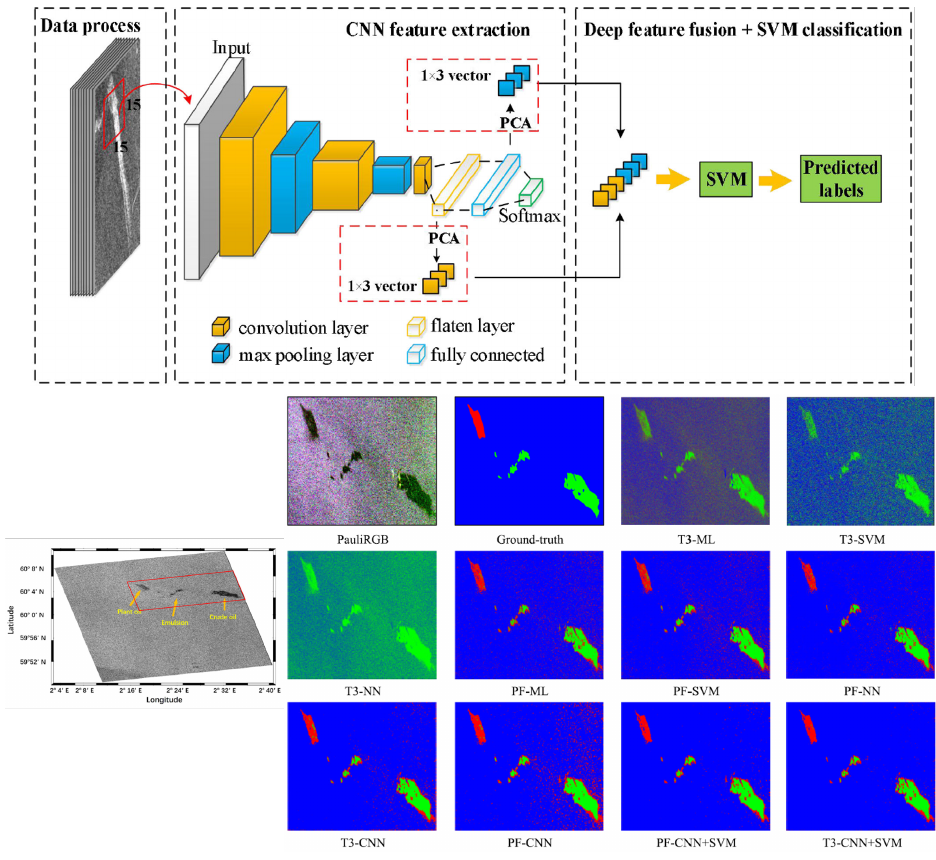
Figure 21. ( Top ) Flowchart of ocean oil spill identification. ( Down ) The marine oil spill detection classification results of different methods for one dataset